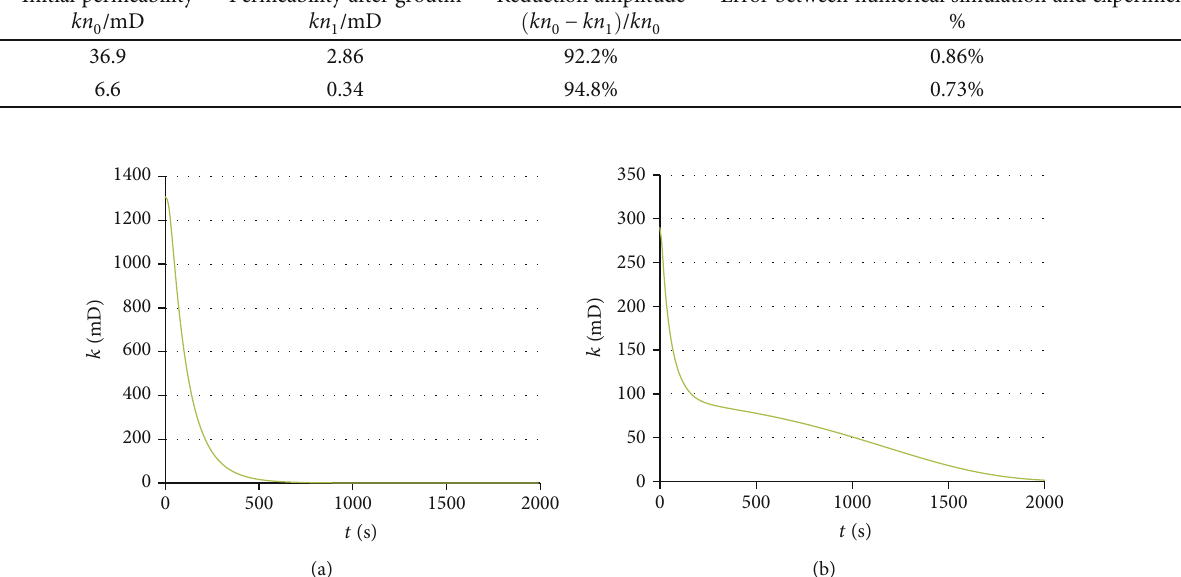
Table 4: Numerical simulation on permeability variations of coal samples before and after grouting. No.